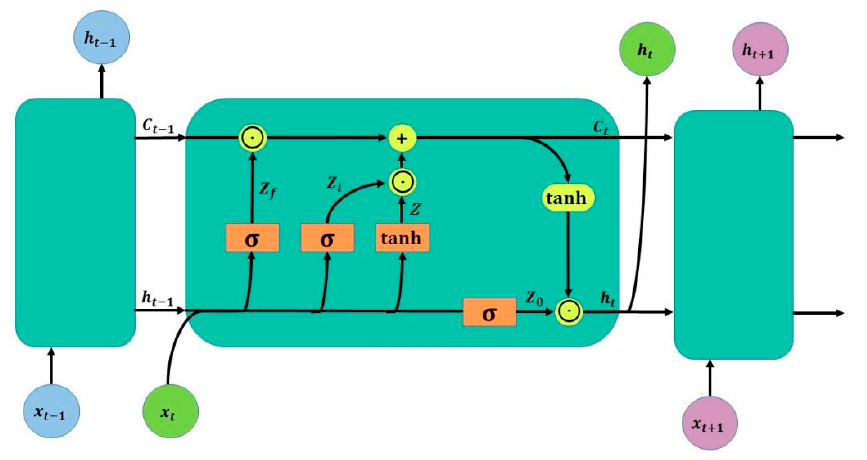
Figure 1. Schematic diagram of LSTM structure.